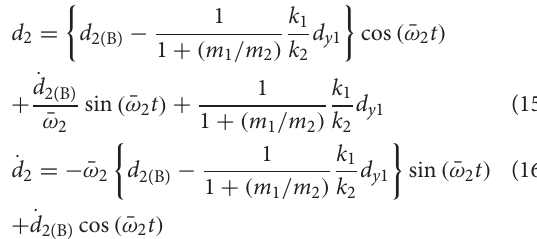
deformation of the first story shown by the blue shaded area in Figure 3A